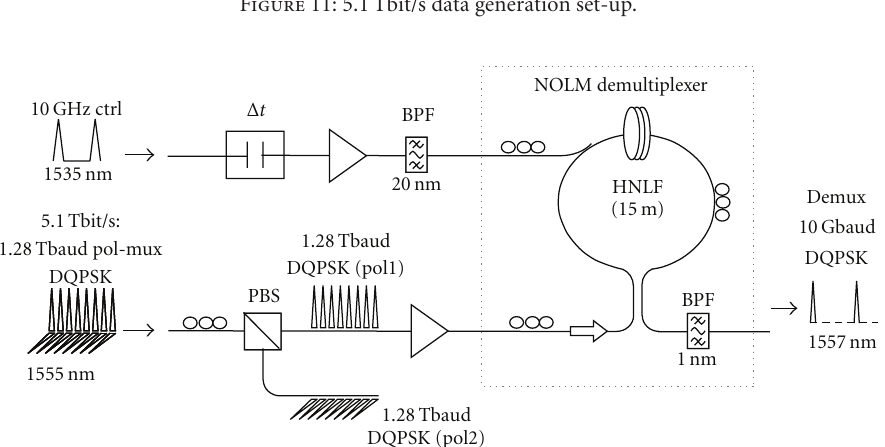
Figure 12: 5.1Tbit/s demultiplexer receiver with a pol-DEMUX (PBS) and an NOLM DEMUX, yielding 10Gbaud